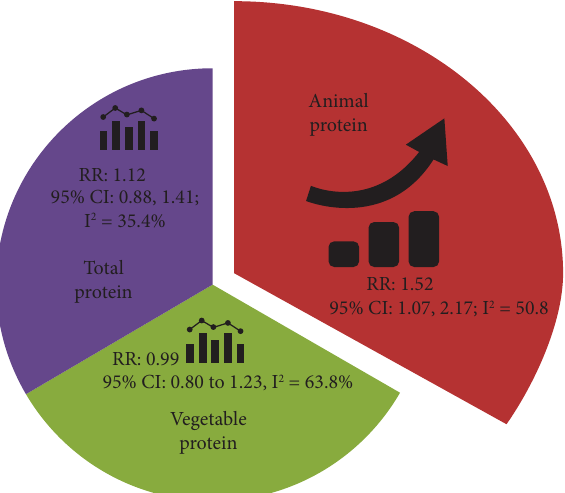
Figure 5: Te chart demonstrates the summary of the study result. It shows increased risk of GDM in patients taking higher amount of animal protein. However, higher total and vegetable proteins intake do not lead to increased GDM